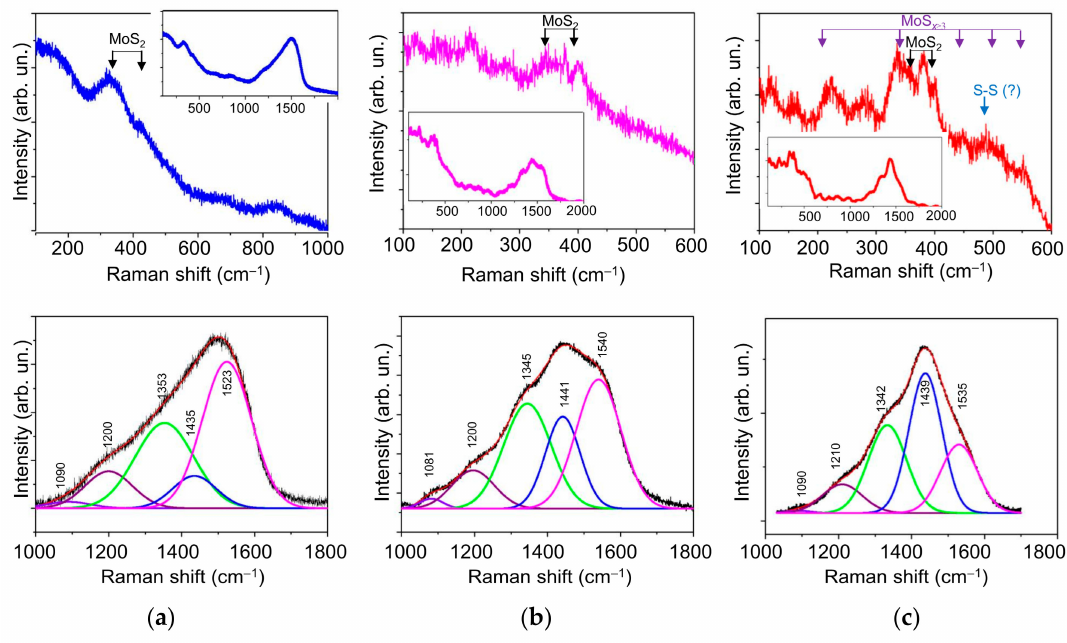
Figure 6. Raman spectra for the Mo–S–C–H thin-film coatings obtained by reactive PLD in the H 2 S gas at pressures of ( a ) 5.5, ( b ) 9, and ( c ) 18 Pa. The regions of Raman shifts corresponding to resonance light scattering by MoS x - and a-C(S,H)-based nanophases are shown at the top and bottom, respectively. The model of spectrum decomposition into the indicated peaks is discussed in the text. Inserts show the Raman spectra in the region from 100 to 2000 cm − 1 that allows a correct comparison of the peak intensities for di ff erent